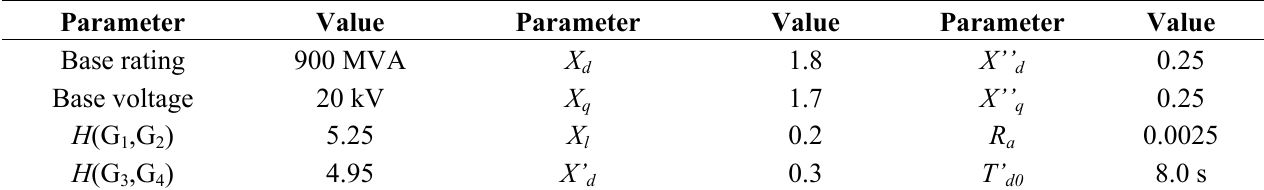
Table A1. The Synchronous Generator Parameters in a Two-Area Four-Generator System.